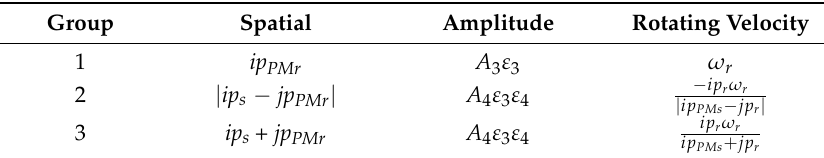
Table 2. Excited harmonic components by the PMs on the